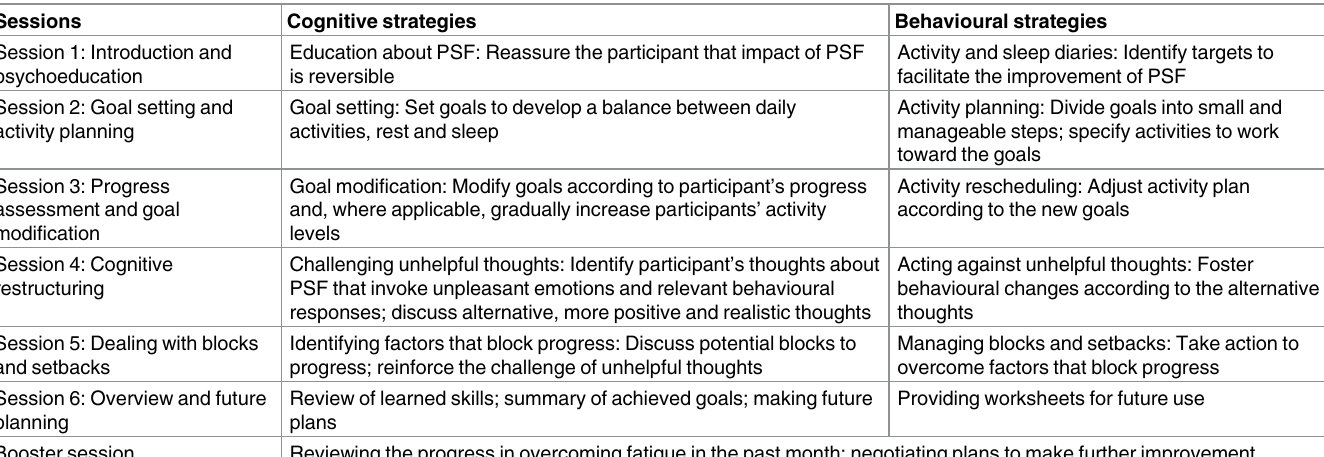
Table 1. Structure and content of intervention